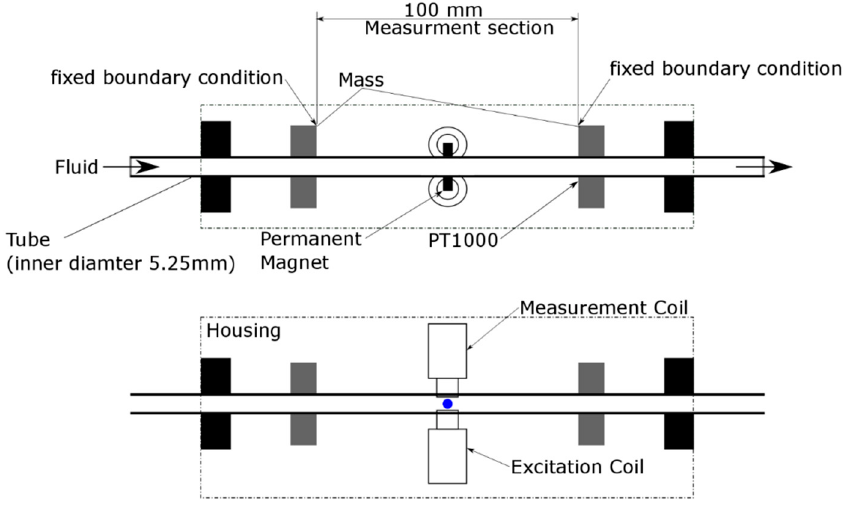
Figure 1. Experimental setup of tubular sensor.